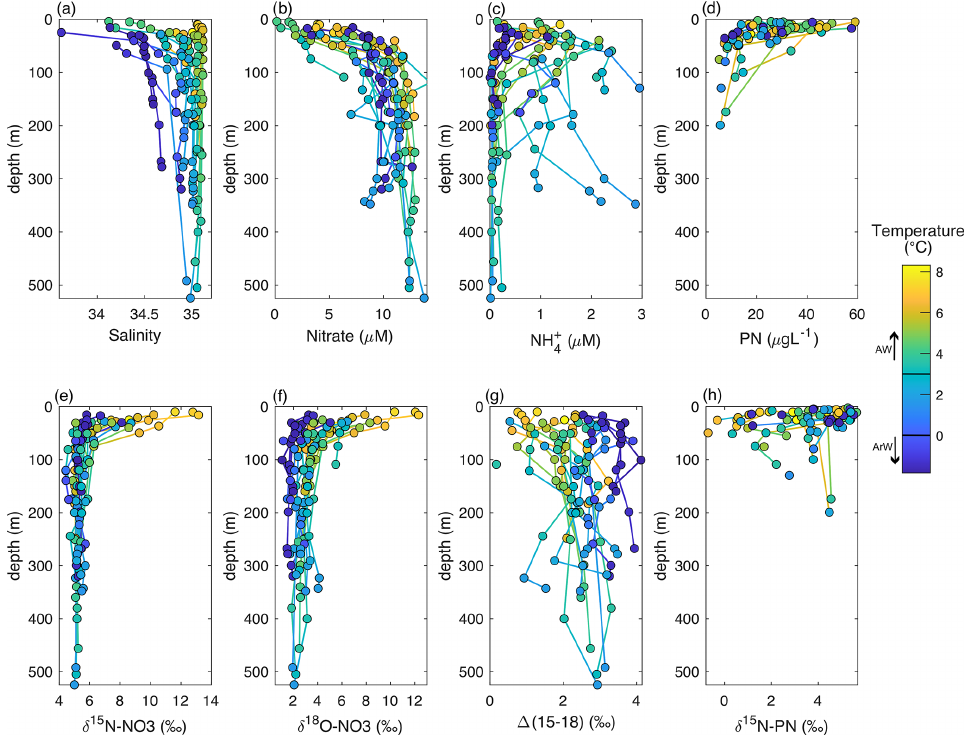
Figure 4. Depth profiles of the upper 500m of the Barents Sea shelf. Colour denotes temperature changes. (a) Salinity, (b) nitrate (µM), (c) NH + (µM), (d) PN (µgL − 1 ), (e) δ 15 N-NO 3 (‰ vs AIR), (f) δ 18 O-NO 3 (‰ vs VSMOW), (g) (cid:49) (15–18) (‰) and (h) δ 15 N-PN (‰ vs 4